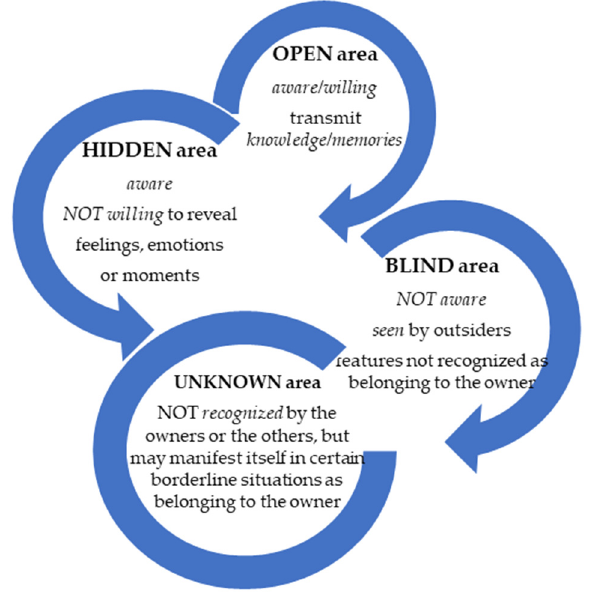
Figure 1. Johari Window model of communication.